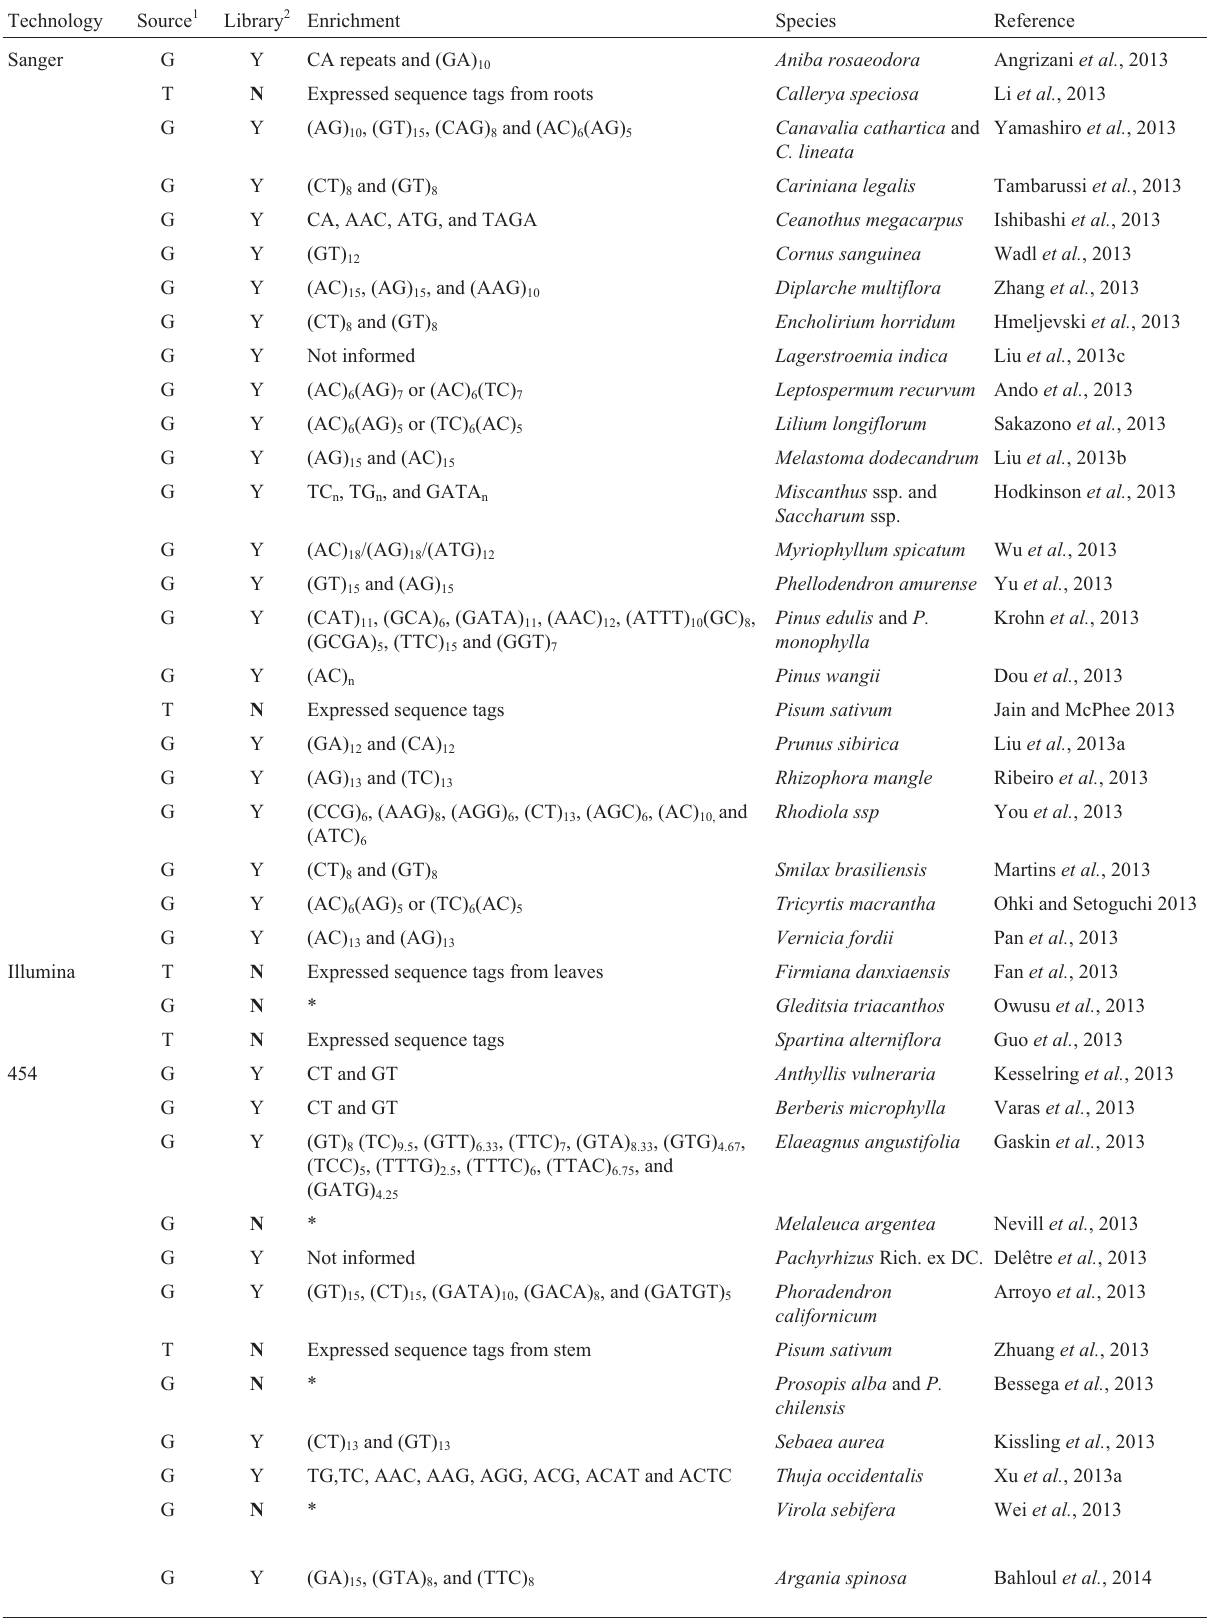
Table 1 - Recent studies involved in the detection and development of SSR markers in plants, using different sequencing technologies.